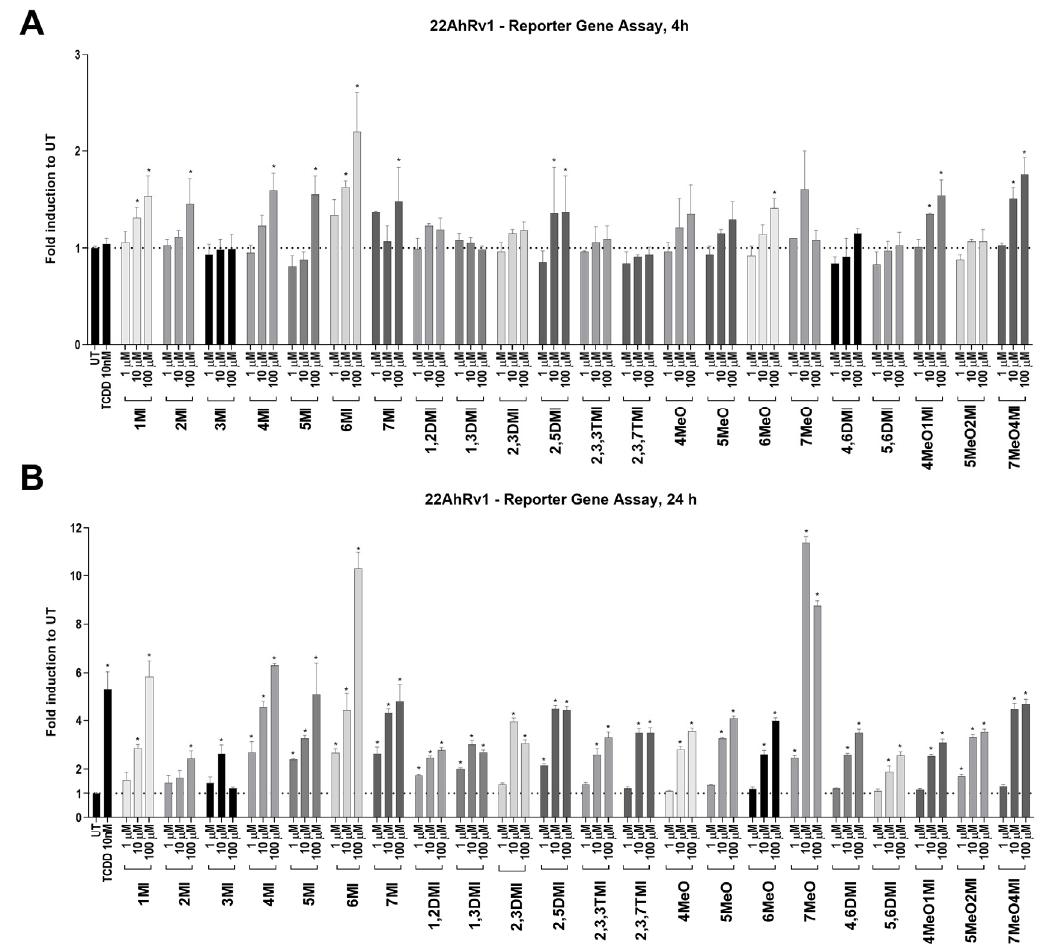
Figure 1. AhR transcription activity after indoles treatment. 22AhRv1 cells were incubated for 4 h ( A ) and 24 h ( B ) with indoles in the concentration range of 1 µM to 100 µM or controls (UT; TCDD 10 nM). The transcription activity of AhR was measured using RGA. The data obtained are averages of three to five experiments and are expressed as fold induction over untreated (UT; DMSO-treated) cells. * represents a significant difference ( p < 0.05) between untreated (UT) and compound-treated cells.